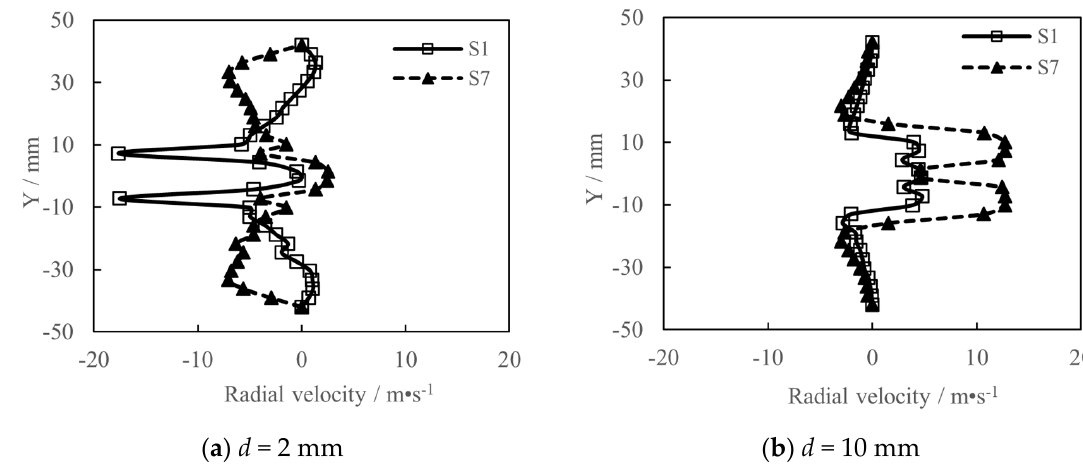
Figure 19. Radial profiles of axial velocity.